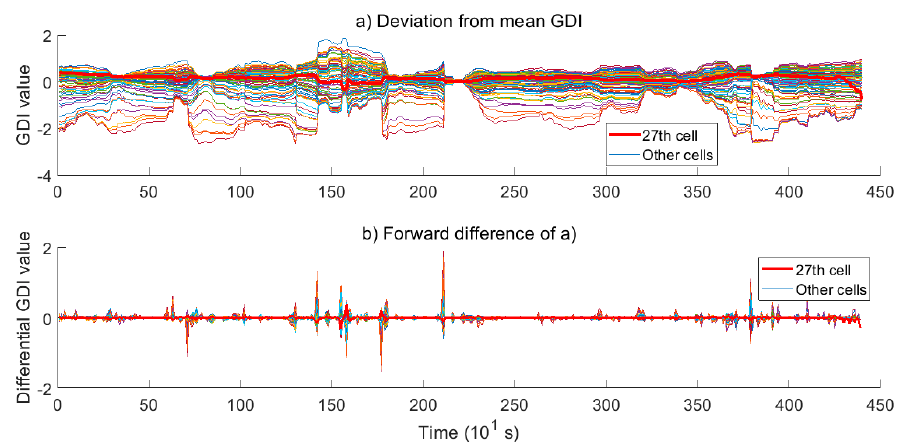
Figure 4. Extracted GDI sequences in the first case, ( a ) the deviation from the mean GDI sequence; ( b ) forward difference of ( a ).